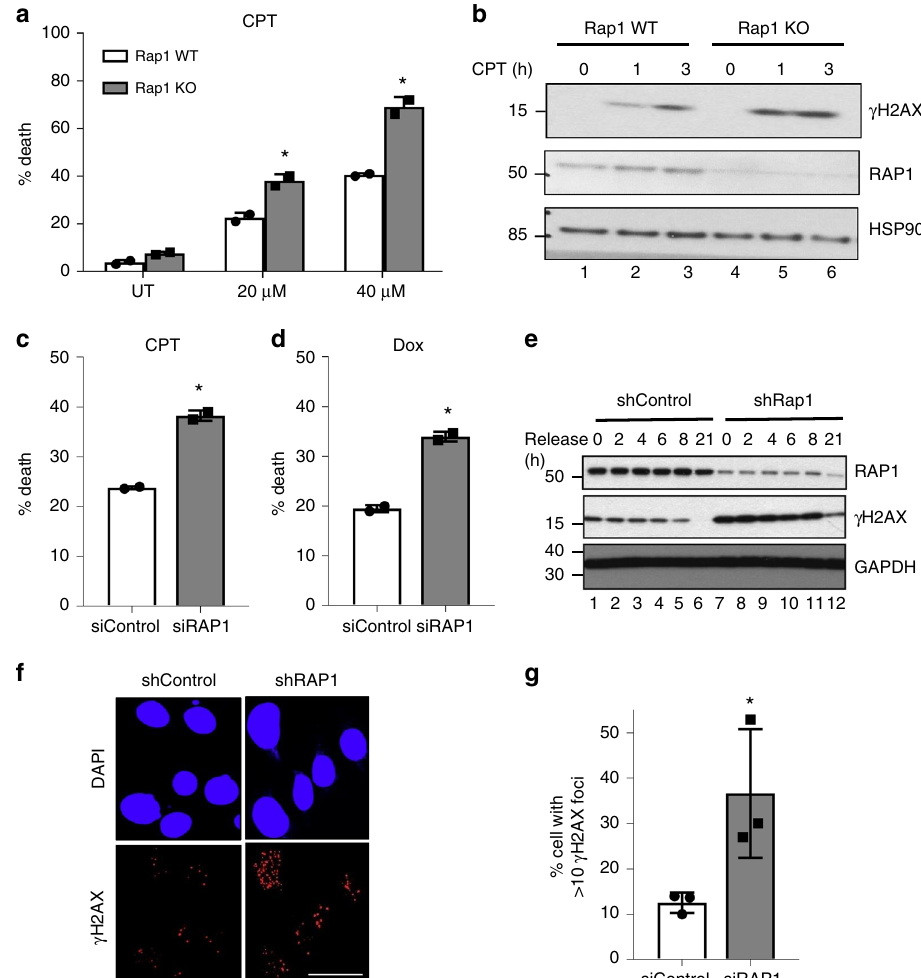
Fig. 4 Rap1 promotes cell survival and DNA damage repair after chemotherapeutic drug treatment. a Rap1 WT and KO MEFs were treated with various doses of CPT and analyzed for cell death after 48 h. Mean± SD of duplicate experiments are presented. * p < 0.05 (two-tailed Student ’ s t -test). b Western blot analysis in Rap1 KO and WT MEFs upon CPT treatment for indicated time points. c , d MCF7 cells were transfected with RAP1 or scrambled control siRNAs and cell survival was measured after 48 h treatment with CPT (60 μ M) or Dox (1 μ M) as indicated. Mean ± SD of the percentage cell death in duplicate experiments is depicted. * p < 0.05 (two-tailed Student ’ s t -test). e Western blot analysis in shControl and shRAP1-transfected MCF7 cells